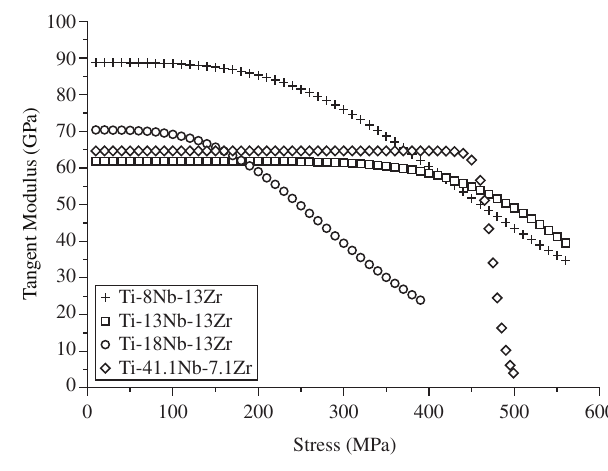
Figure 4. Tangent modulus versus stress for Ti-Nb-Zr alloys.